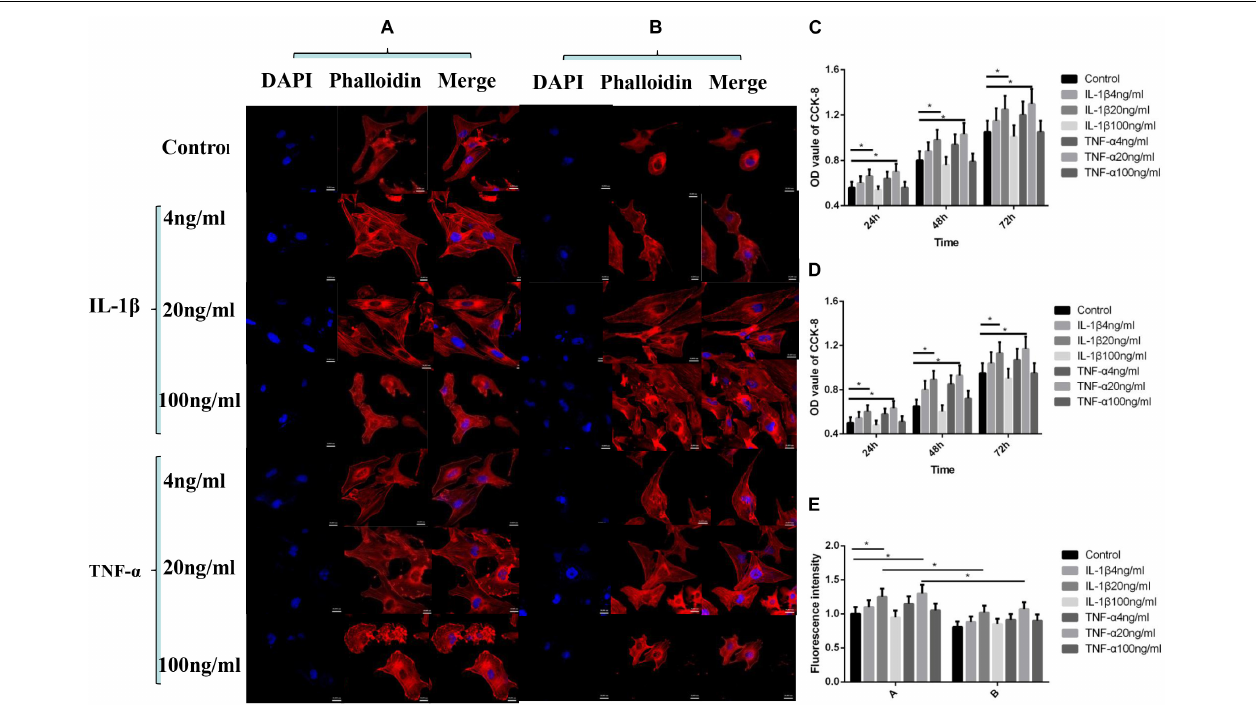
FIGURE 1 | Effects of IL-1 β and TNF- α on proliferation and cytoskeleton of vascular endothelial cells. Mean ± standard deviation (SD) denote the experimental results; * indicates P < 0.05. (A) Samples without P311 siRNA intervention. (B) Samples with P311 siRNA intervention. (C) Statistical cell proliferation results of A . (D) Statistical cell proliferation results of B . (E) Representative cell skeleton staining images of A and B .